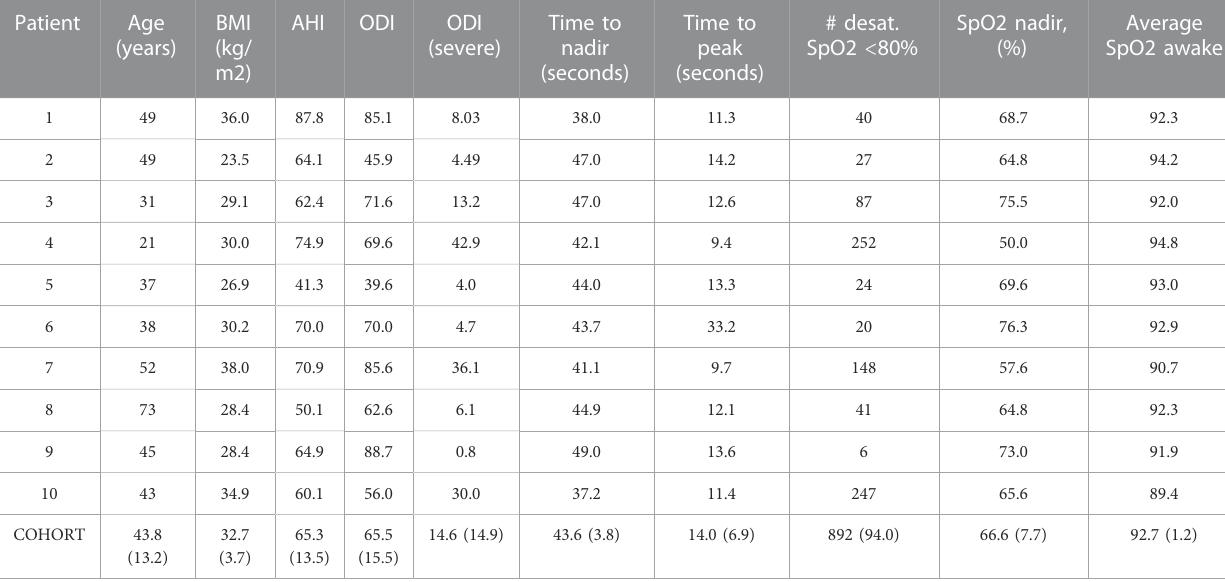
TABLE 1 OSA patient ’ s characteristics and polysomnographic analysis. Patient